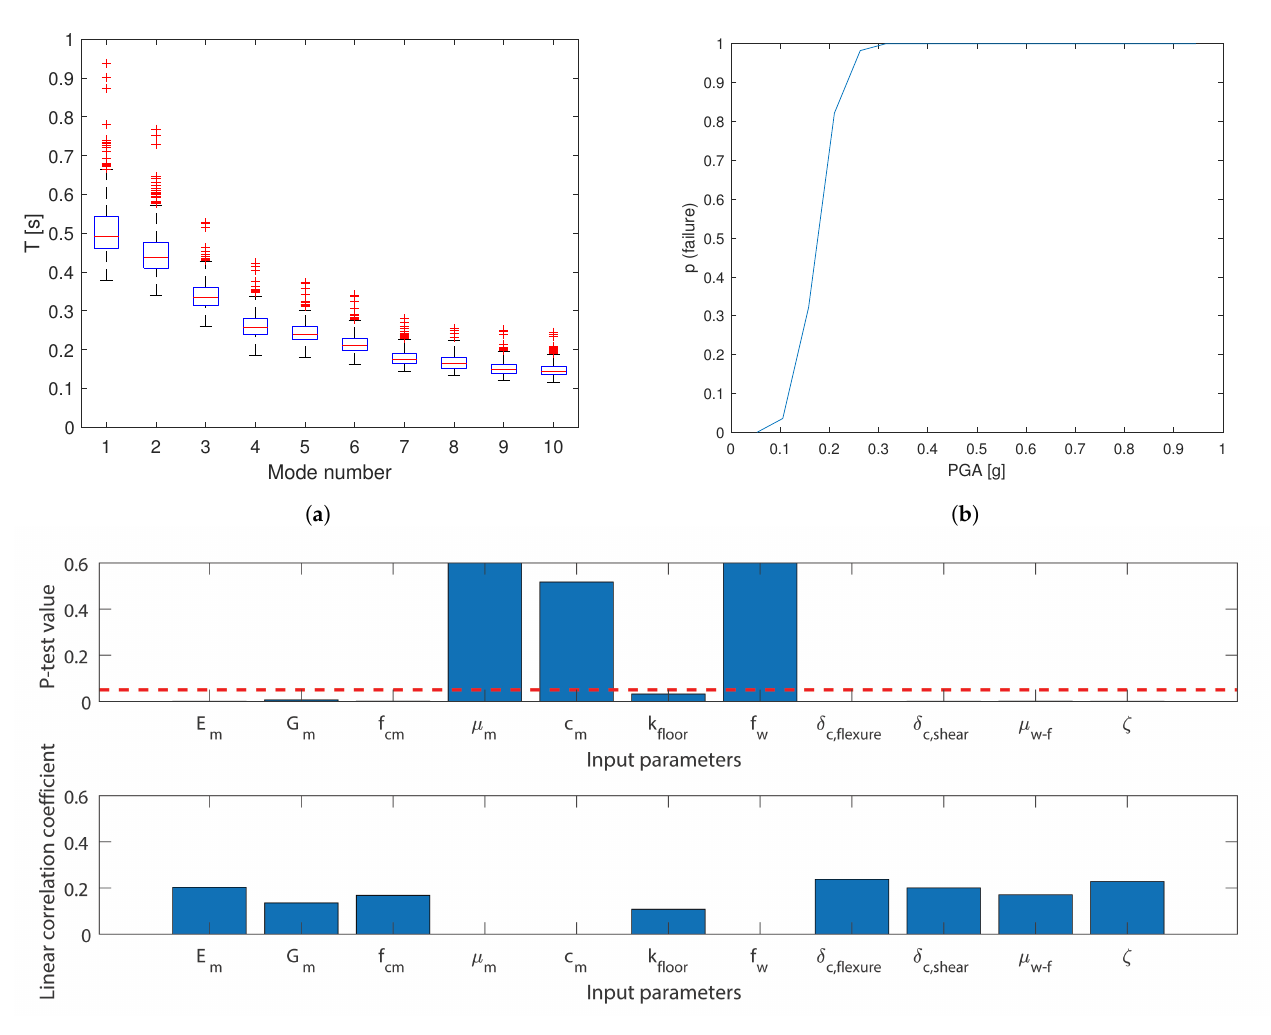
Figure 18. Lausanne Malley model: ( a ) Distribution of modal periods. ( b ) Fragility curve. ( c ) Correlations between PGA at failure and input